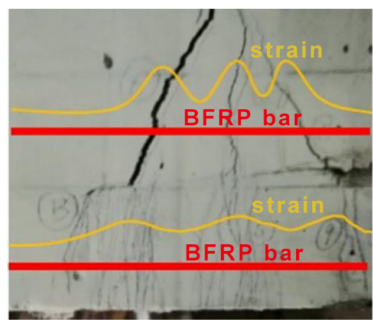
Figure 16. Strain distribution assuming two BFRP bars (red solid line) are embedded in the SSC and UHDCC